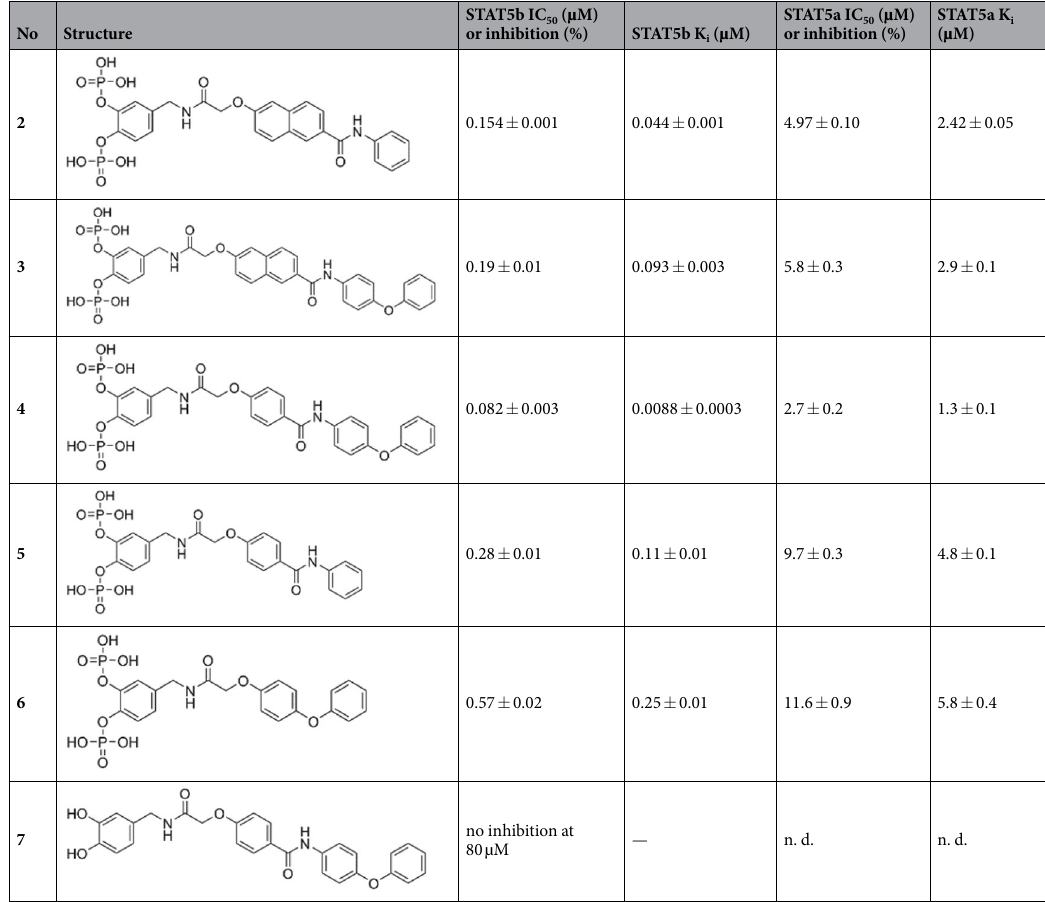
Table 1. Activities of test compounds against the SH2 domains of STAT5b and STAT5a in fluorescence polarization assays. n. d.: not determined. Data for 2 are taken from the literature 15 . Mean values ± standard deviations (s.d.) from three independent experiments are given. IC 50 data were converted to K i -values using the published equation 31